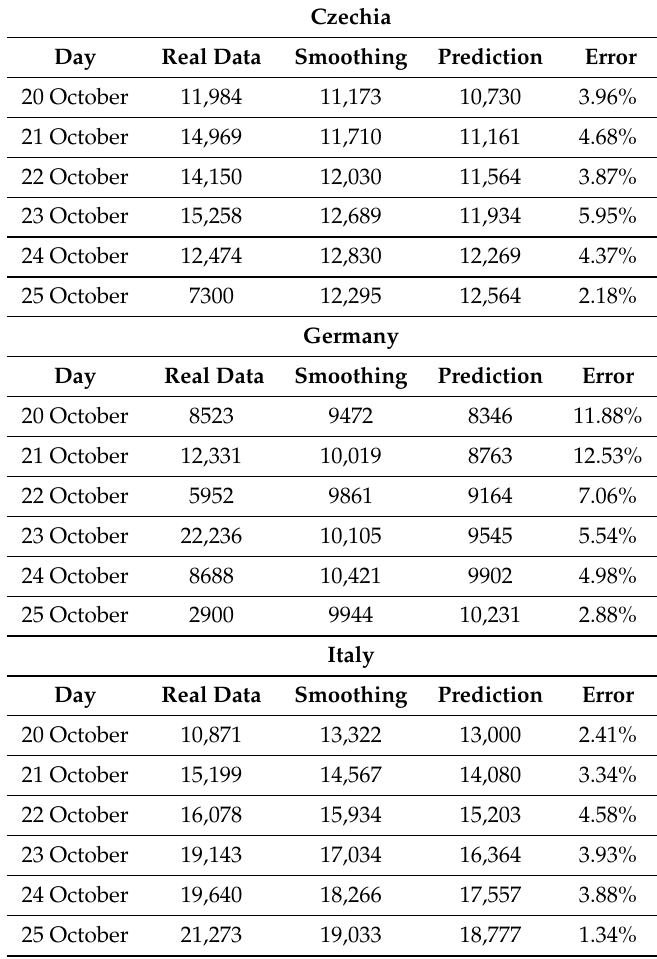
Table 1. Prediction by log-normal wavelet model for Czechia, Germany, Italy from 20 October to 25